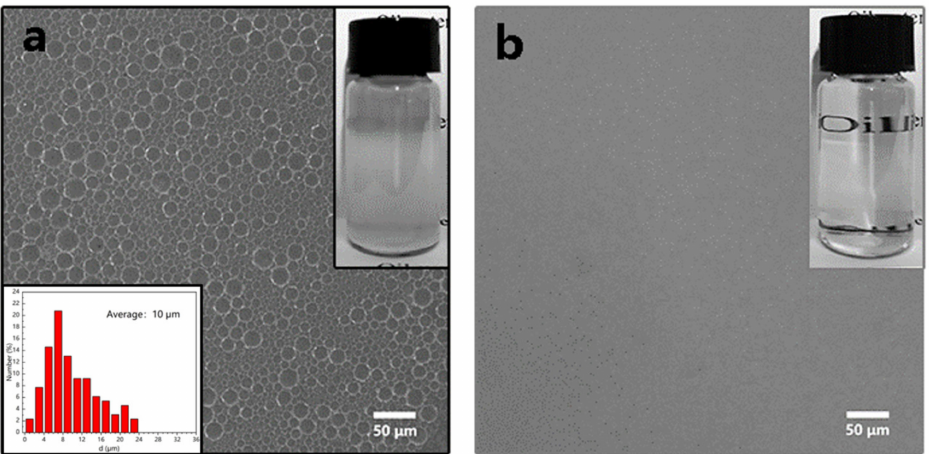
Figure 8. The microscopic and optical images of surfactant-stabilized water-in-oil emulsions